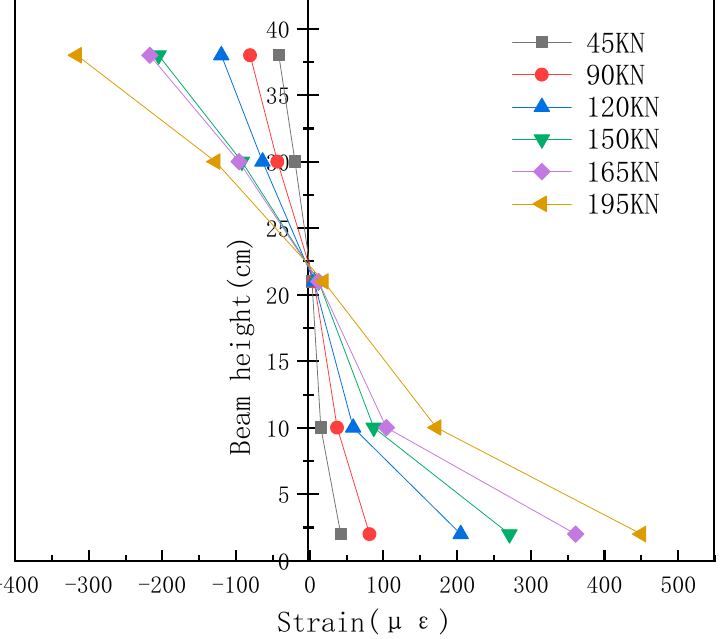
Figure 15. Strain of test beam L0 along beam height.